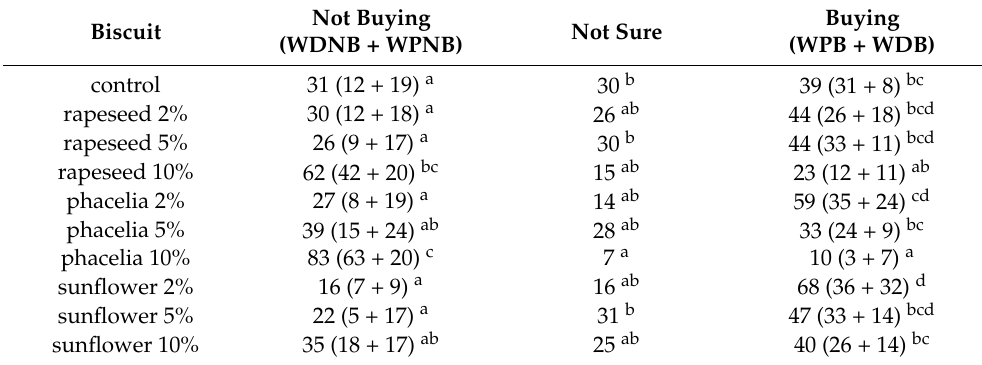
Table 11. Consumers’ purchase intention for